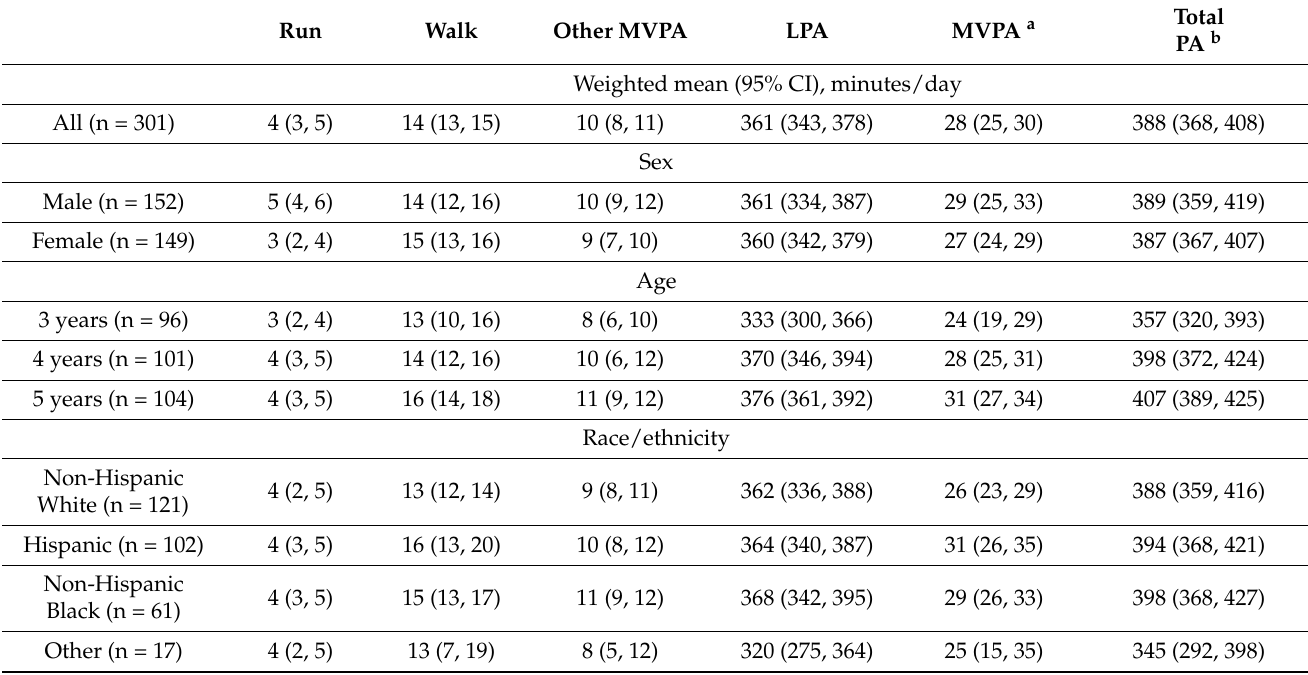
Table 1. Estimated daily minutes spent in physical activity in U.S. preschool-aged children. The 2012